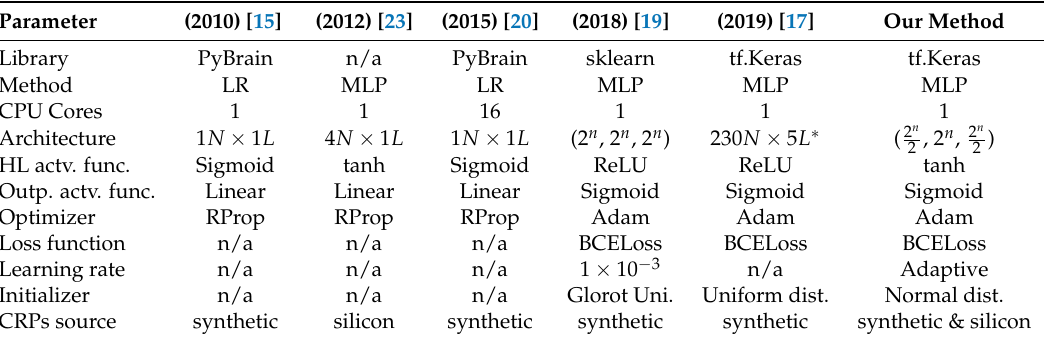
Figure 4. A deep feed forward neural network architecture for 3-XOR 64-bit. Since n is equal 3, the first and third hidden layers consists of four neurons, while eight for the second hidden layer. The architecture changes based on the number of streams in an n -XPUF. Table 1. Parameters of machine learning attack